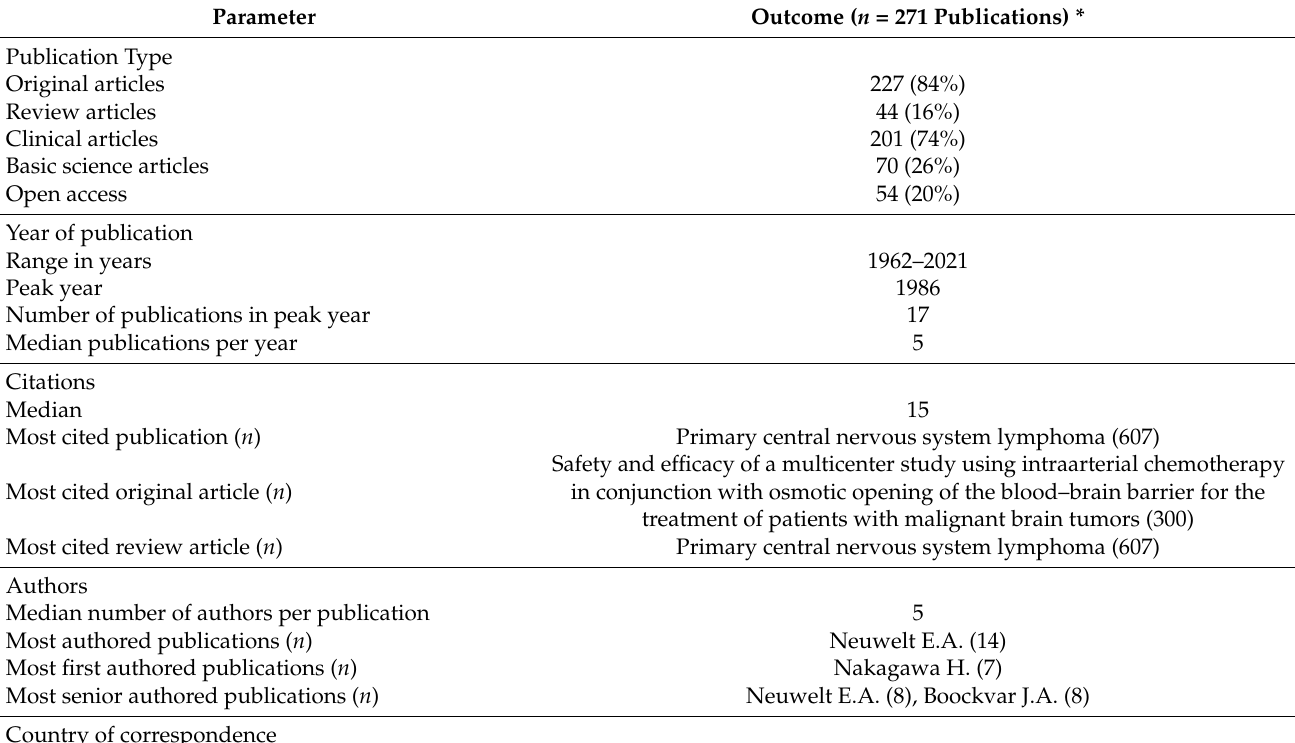
Table 1. Summary of article